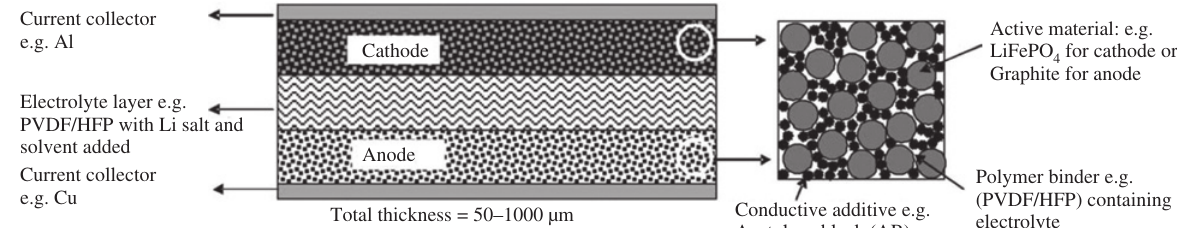
Figure 5: Schematic diagram of a thick-film cell. Reprinted from